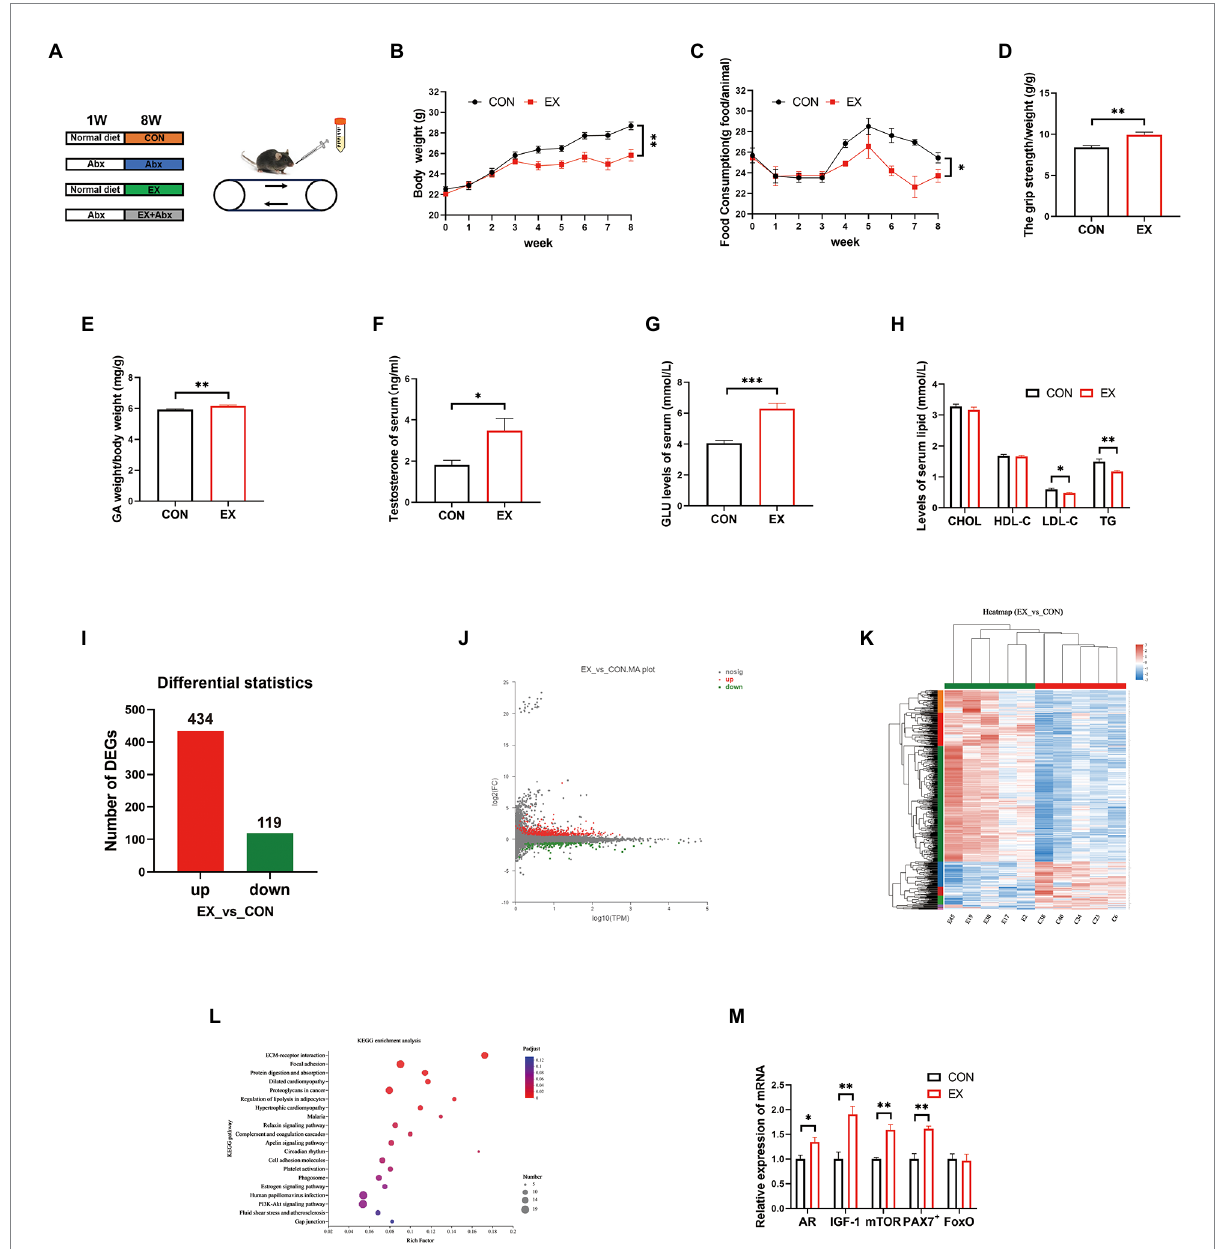
FIGURE 1 High loading intensity of aerobic exercise improved skeletal muscle performance (CON vs. EX). (A) Mice were subjected to treadmill training and antibiotic treatment for 8 weeks (CON, Abx, EX, and EX + Abx). (B) Body weight. (C) Food intake. (D) Grip strength. (E) GA percentage. (F) Serum testosterone levels. (G) Serum GLU levels. (H) Serum lipids levels. (I) Differentially expressed genes (DEGs). (J) MA plot. (K) Heat map of DEGs. (L) KEGG_pathway of DEGs. (M) The expression of related genes (AR, IGF-1, mTOR, PAX7+, and FoxO) by qPCR ( ∗ p < 0.05; ∗∗ p < 0.01; ∗∗∗ p <